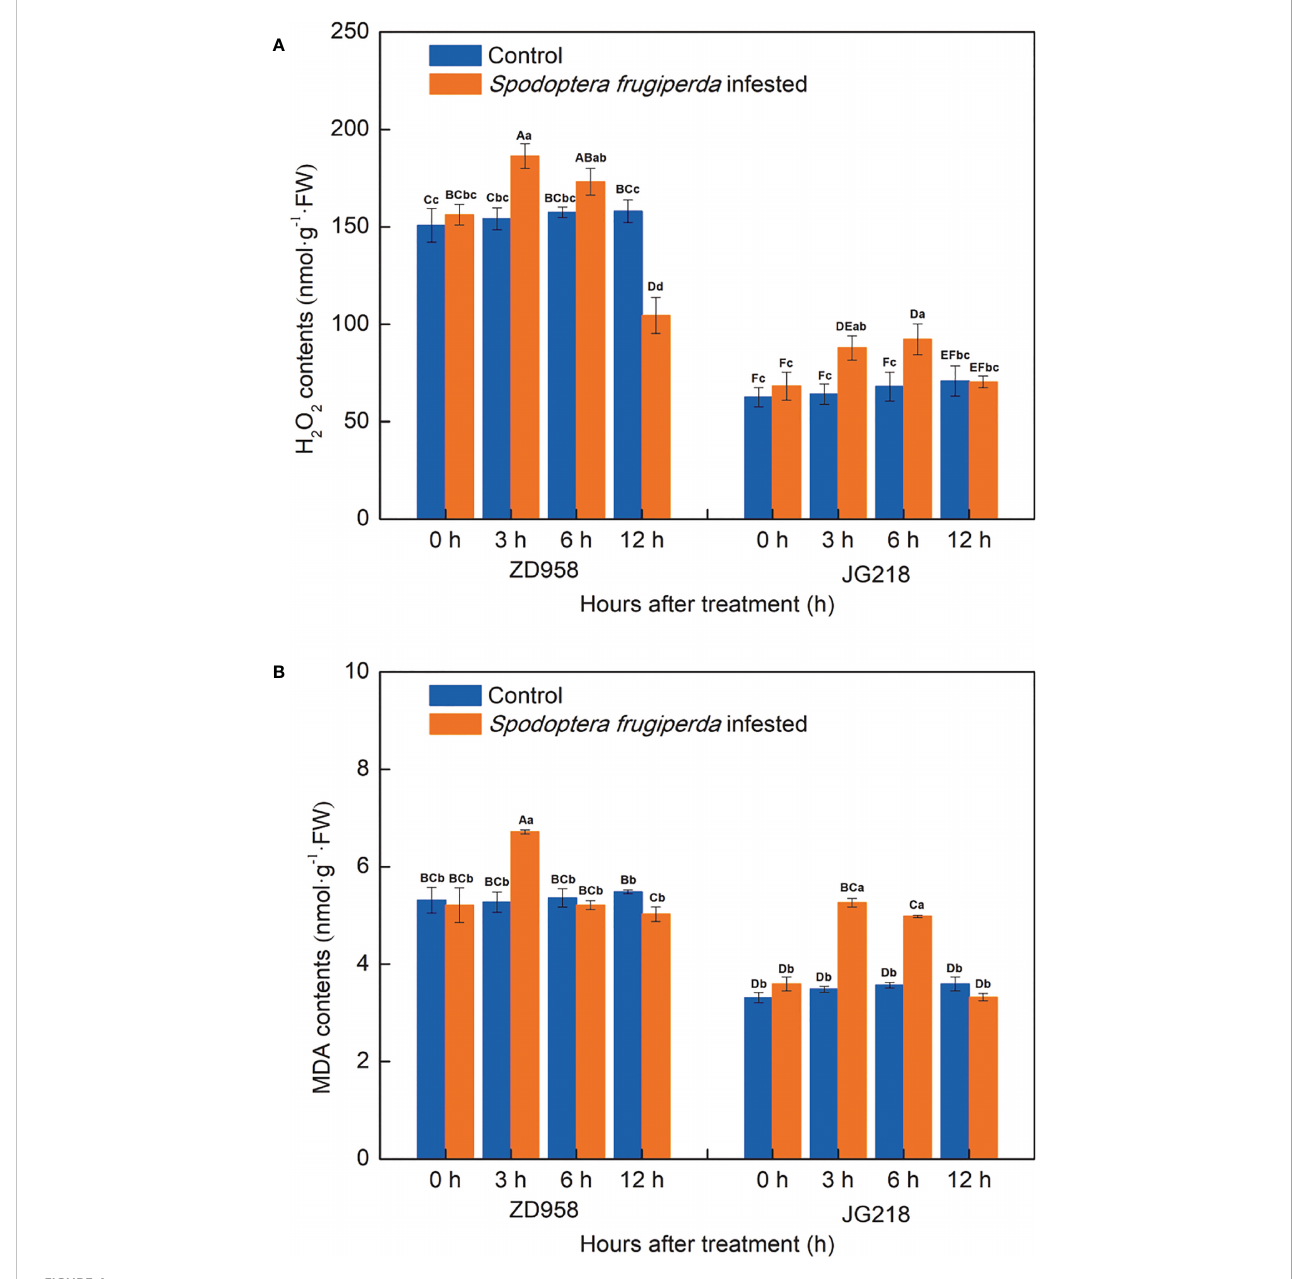
FIGURE 4 Effect of S. frugiperda infestation on H 2 O 2 (A) and malondialdehyde (B) concentration in maize leaves. Data are shown as means ± SD ( n = 3, every n represents the mean of three seedlings). Different letters indicate signi fi cant differences at P < 0.05. Capital letters represent differences between the two maize cultivars, while lowercase letters indicate differences between treatments within the same